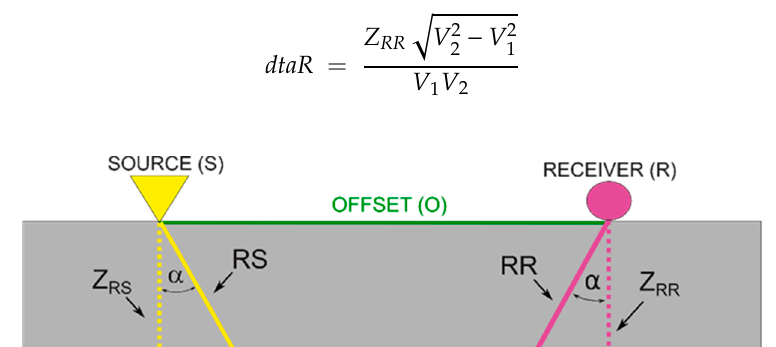
Figure 6. Three ‐ dimensional seismic survey acquisition on the map refractor’s velocity and azimuths; the yellow triangle is a source, and the pink ovals are receivers.